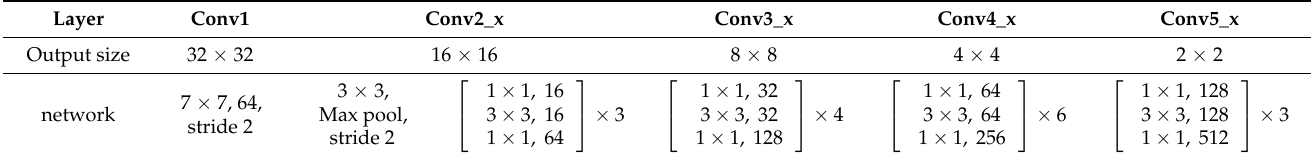
Table 1. Architecture of the deep residual network designed in this paper.